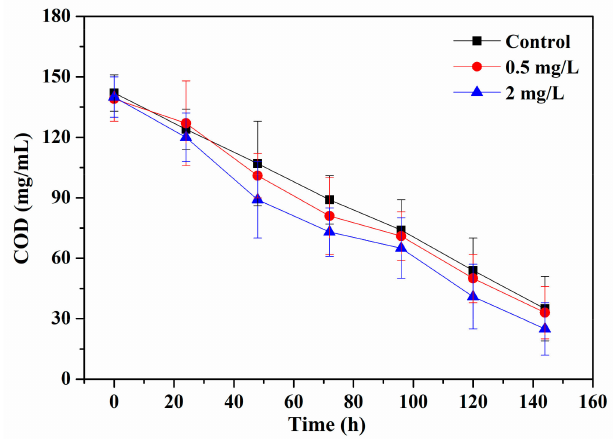
Figure 5. Dynamic changes of chemical oxygen demand in synthetic wastewater by periphyton after exposure to 0.5 and 2 mg / L Cu 2 + , and the